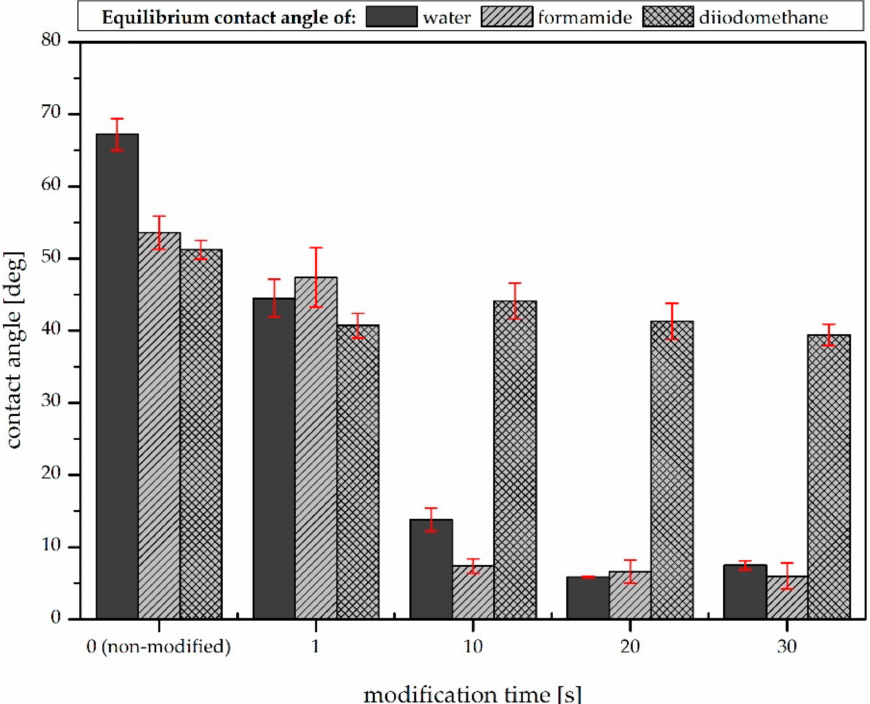
Figure 3. Surface wettability (water, formamide, and diiodomethane equilibrium contact angles) versus modification